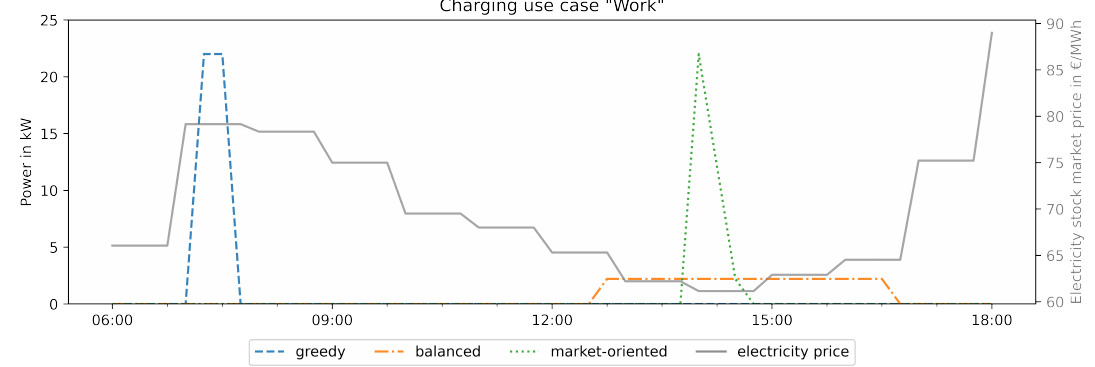
Figure 3. Different charging strategies for one passenger car at